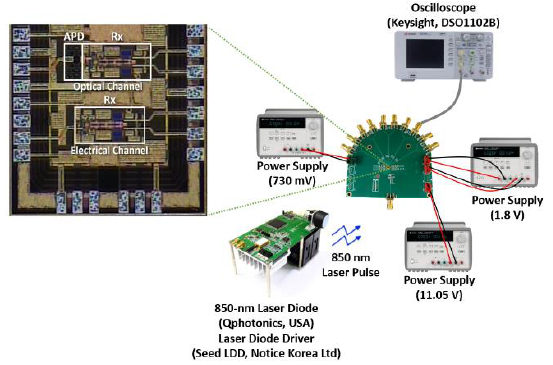
Figure 8. Chip microphotograph of the proposed optoelectronic Rx IC and its test setup.